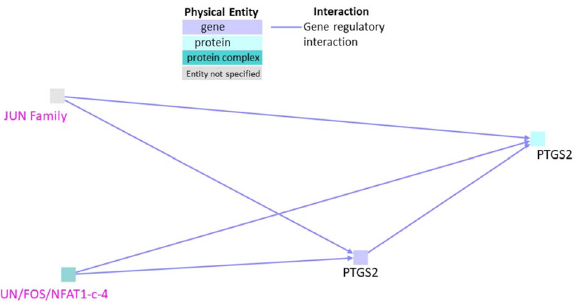
Figure 2. Interactions between genes that are upregulated both in neurotoxicity and cardiotoxicity. Black labels denote seed nodes and pink labels denote intermediate nodes. Each line represents an interaction. Grey square (JUN family) indicates that the entity whether gene/protein/compound etc. was not specified by the